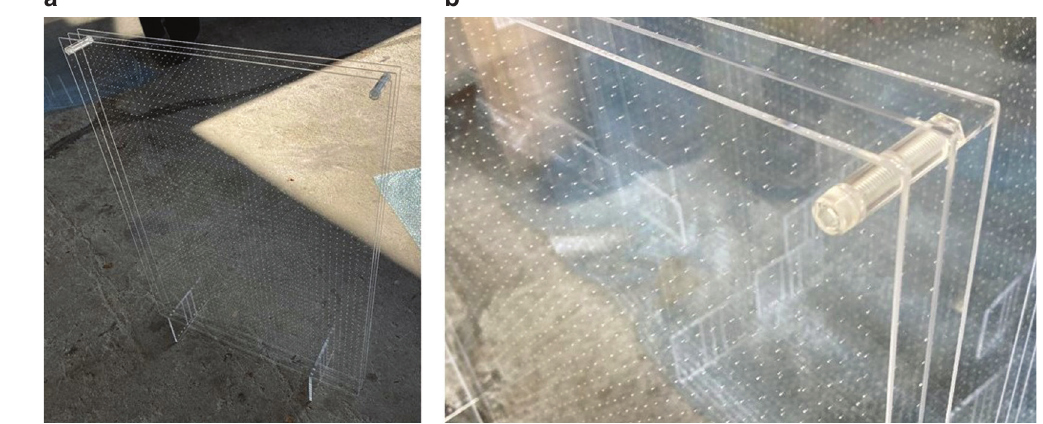
(a), (b) Photographs of Specimen (a). Detailed information of its characteristics is given in Fig.